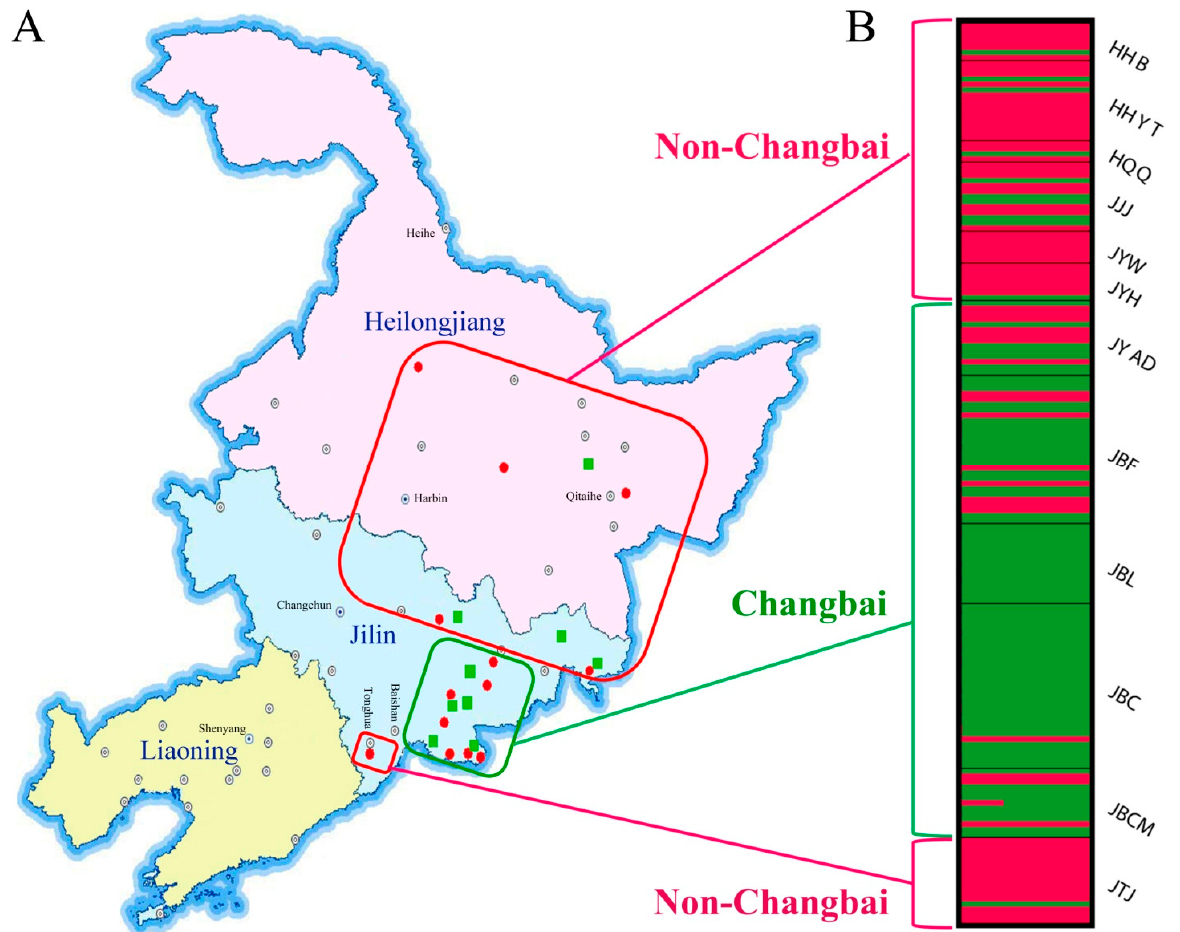
Figure 1. Population structure of Cylindrocarpon -like fungi from ginseng roots representing 22 locations in Northeast China. ( A ) Map showing sampling locations for Panax ginseng (red dot) and P. quinquefolius (green square). ( B ) Two clusters ( K = 2) were identified from 12 populations according to the program STRUCTURE. Green rectangles represent all Changbai groups, and red rectangles represent non-Changbai group.